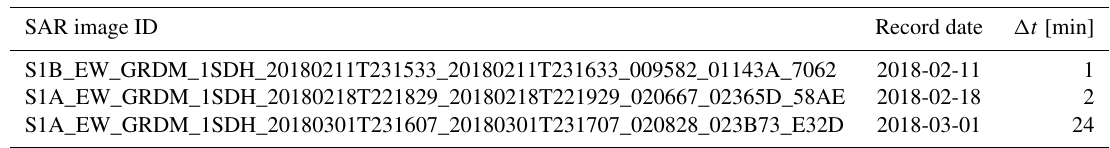
Table A2. SAR images shown in Figs. 4 and 6 and record date and time difference ( (cid:49)t ) to CryoSat-2 observations in minutes (absolute value).